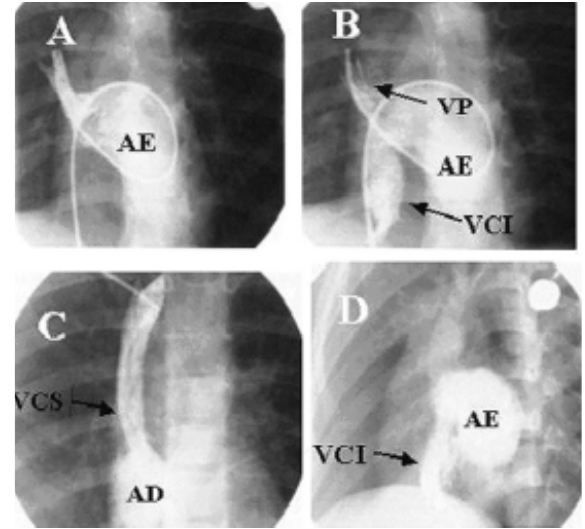
Fig. 3 - Caso 3: A e B – Cateter introduzido pela veia femoral